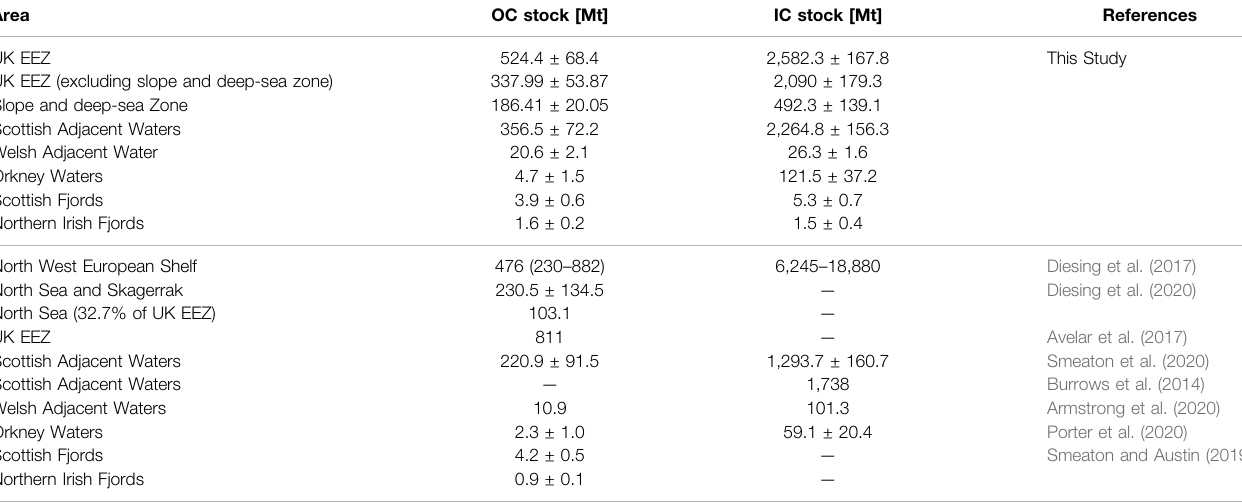
TABLE 4 | Comparisons of the estimated sur fi cial sediment OC and IC stocks (Mt) from this study in comparison to published data from NW Europe.